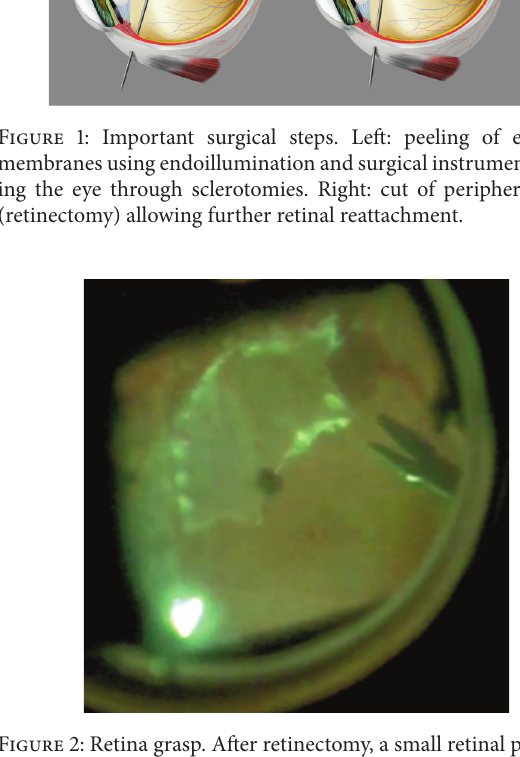
Figure 2: Retina grasp. After retinectomy, a small retinal portion is grasped with nontraumatic forceps and is removed from the